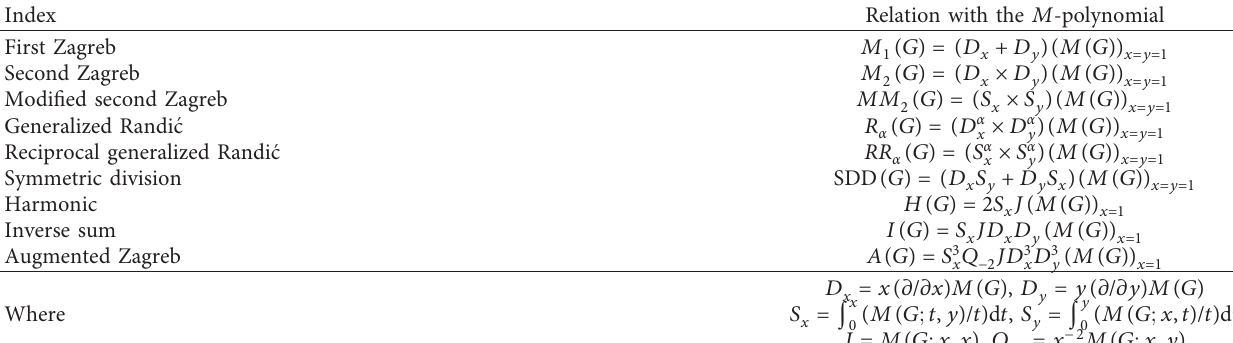
Table 1: Relations of indices with M -polynomial.